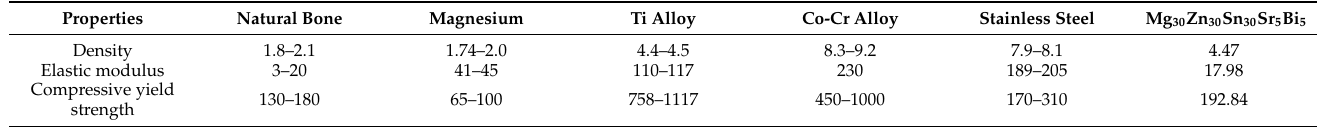
Table 2. The performance comparison between human bone, common biological implant